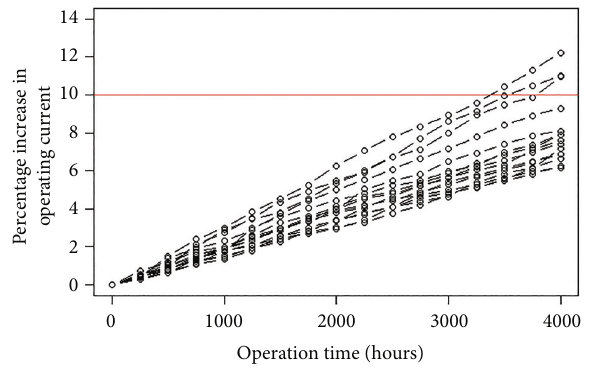
Figure 10: GaAs laser sample degradation